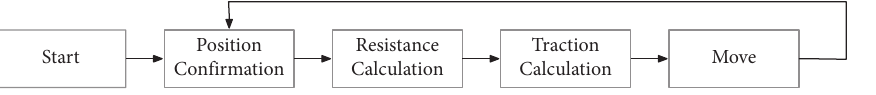
Figure 2: Workflow of the vehicle in the CAV platoon. Table 1: Parameters of the vehicles in platoon.